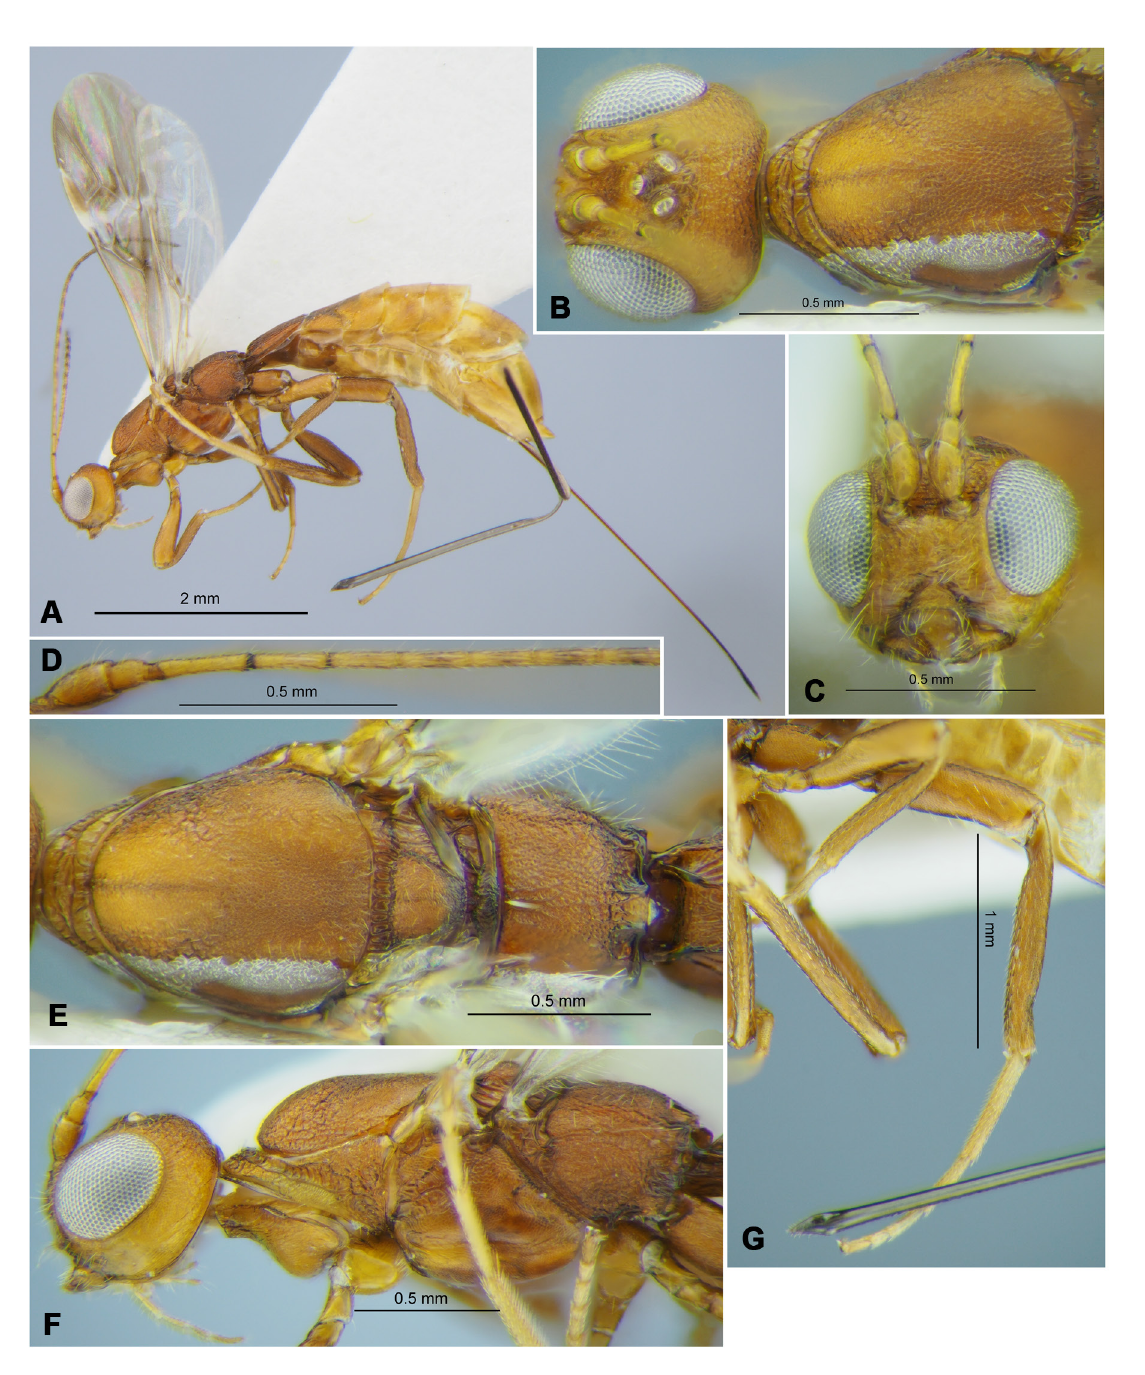
Fig. 26. Hecabalodes anthaxiae Wilkinson, 1929, ♀ (RMNH). A . Habitus, lateral view. B . Head and mesoscutum, dorsal view. C . Head, front view. D . Basal segments of antenna. E . Mesosoma, dorsal view. F . Head and mesosoma, lateral view. G . Hind